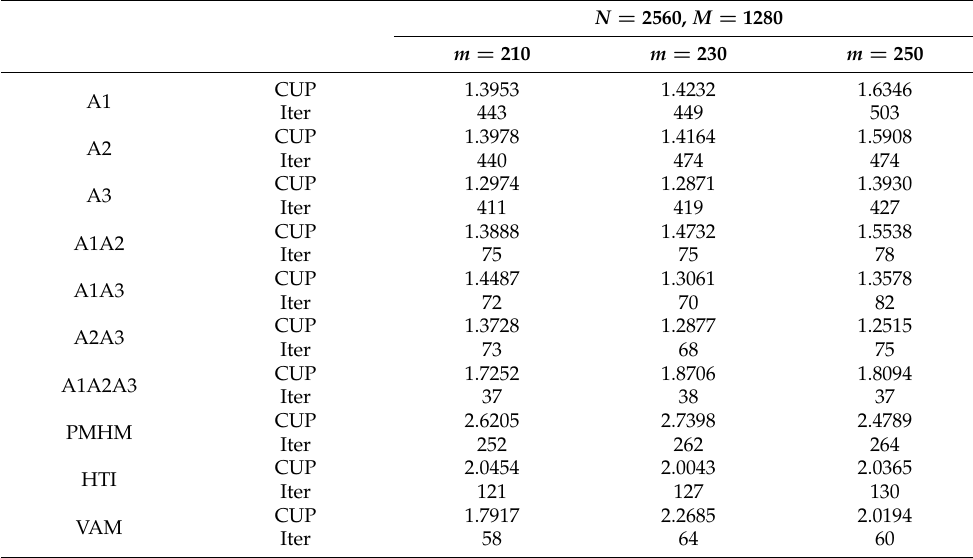
Table 7. The computational results for solving the LASSO problem.